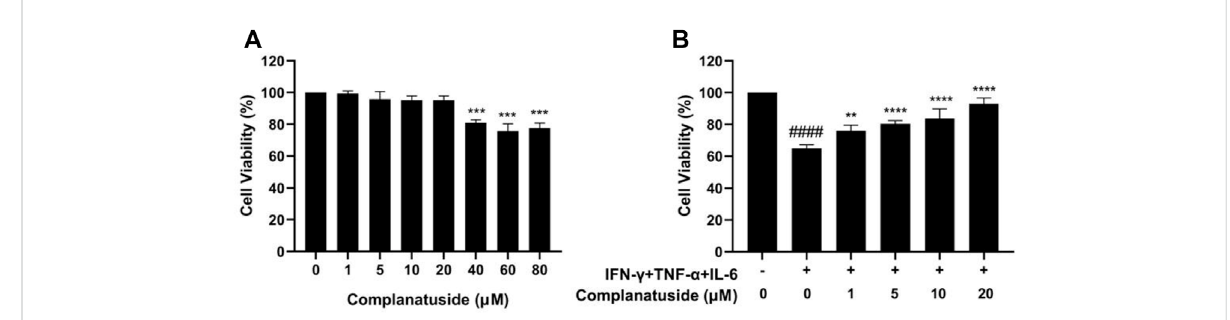
FIGURE 3 EffectsofcomplanatusideontheviabilityofHaCaTcellswithorwithoutthecytokinecombinationtreatment. (A) HaCaTcellsweretreatedwith variousconcentrationsofcomplanatusidefor24 h.TheMTTassaywasusedtodetermine cellviability.Theresultswereshownasmean±SD( n =3), *** = p < 0.001 as compared with control cells. (B) HaCaT cells were treated with various concentrations of complanatuside in the absence or presenceofcytokinecombinationandthecellviabilitywasdeterminedbyMTTassay.Mean±SDfromthreeseparateexperimentswereshown. #### = p < 0.0001 as compared with control group, *** = p < 0.001, and **** = p < 0.0001 as compared with cells treated with cytokine